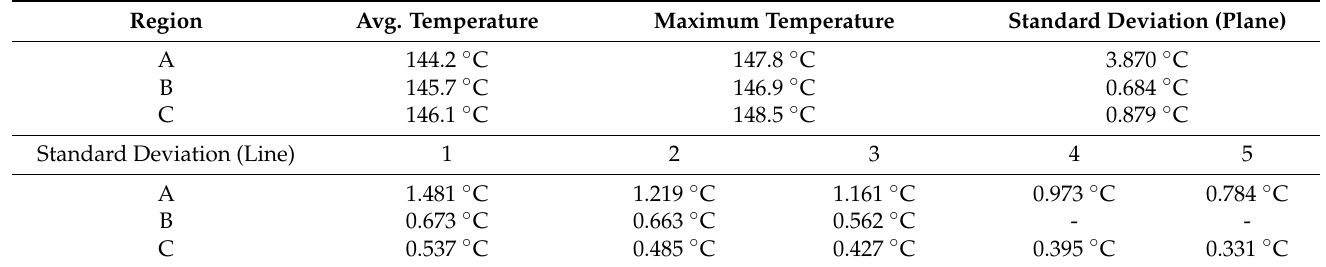
Table 3. Standard deviations of the web temperature distribution in the dryer.